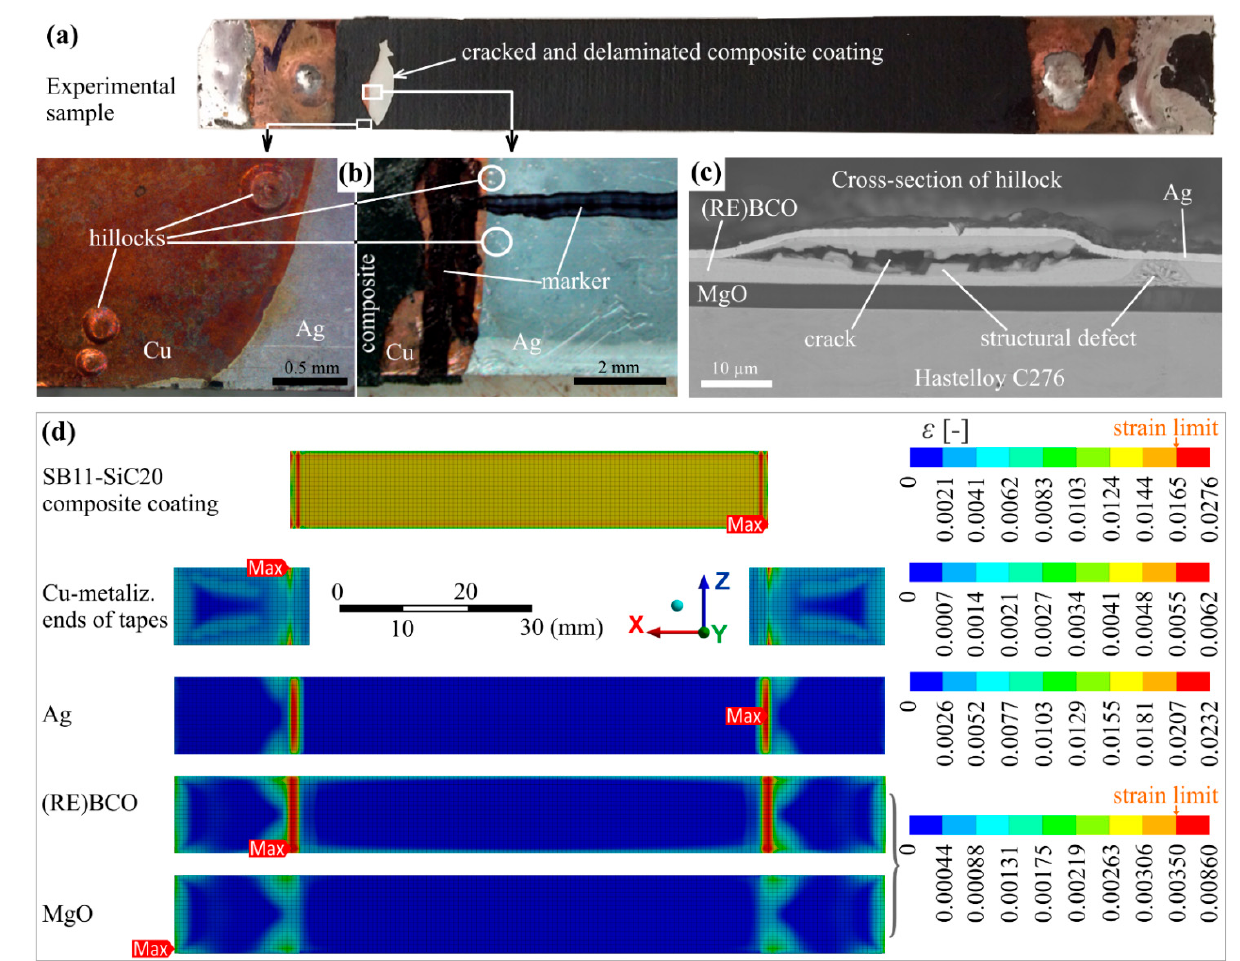
Figure 11. ( a ) Coated HTS tape with the SB11-SiC20 coating after 10 limitation cycles (E = 150 V/m, LN2, 50 ms DC pulse); ( b ) damage localized at the place of a cracked composite in form of hillocks visible in a light microscope; ( c ) SEM cross-section image of a hillock-like defect found in the place marked by circle in ( b ); ( d ) modeling results of a strain distribution in particular layers (top views) of the HTS tape modified with the SB11-SiC20 of 200 µm thickness and quenched at 150 °C.